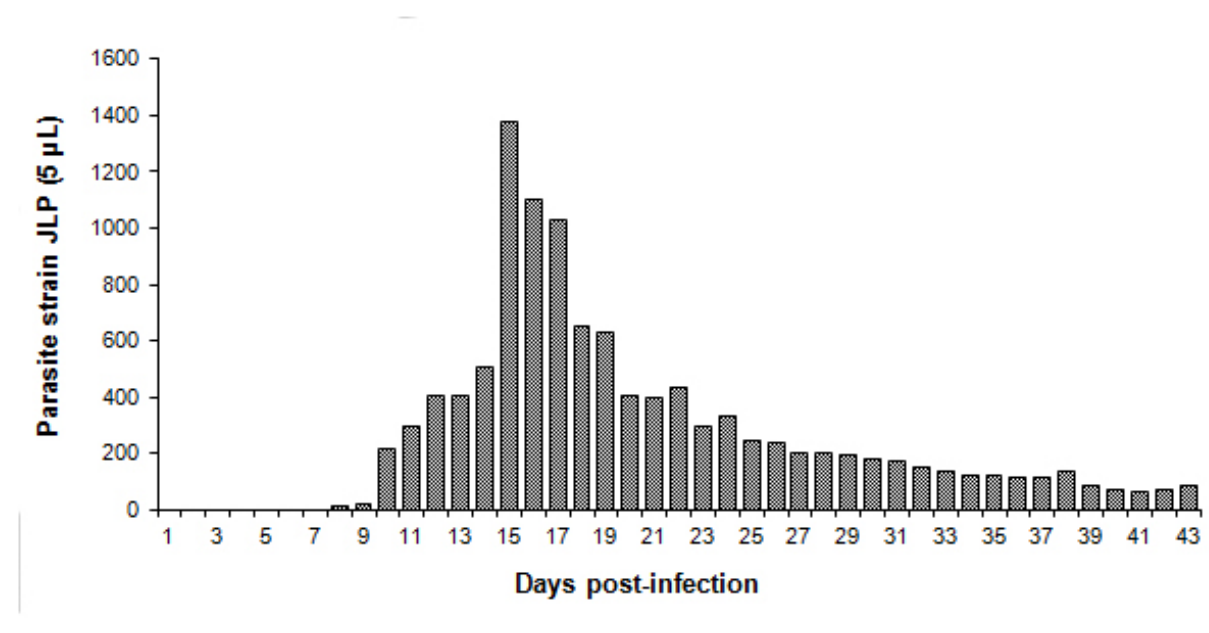
Figure 2. Parasite load in BALB/c mice after infection with 1 x 10 5 trypomastigotes/mL of T. cruzi strain JLP . Data represent mean number of parasites (ten mice per group).